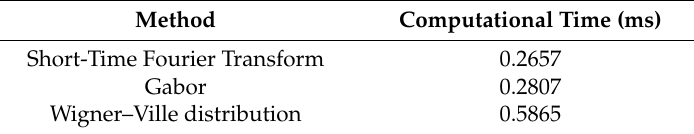
Table 2. Computational time of time-frequency estimators.